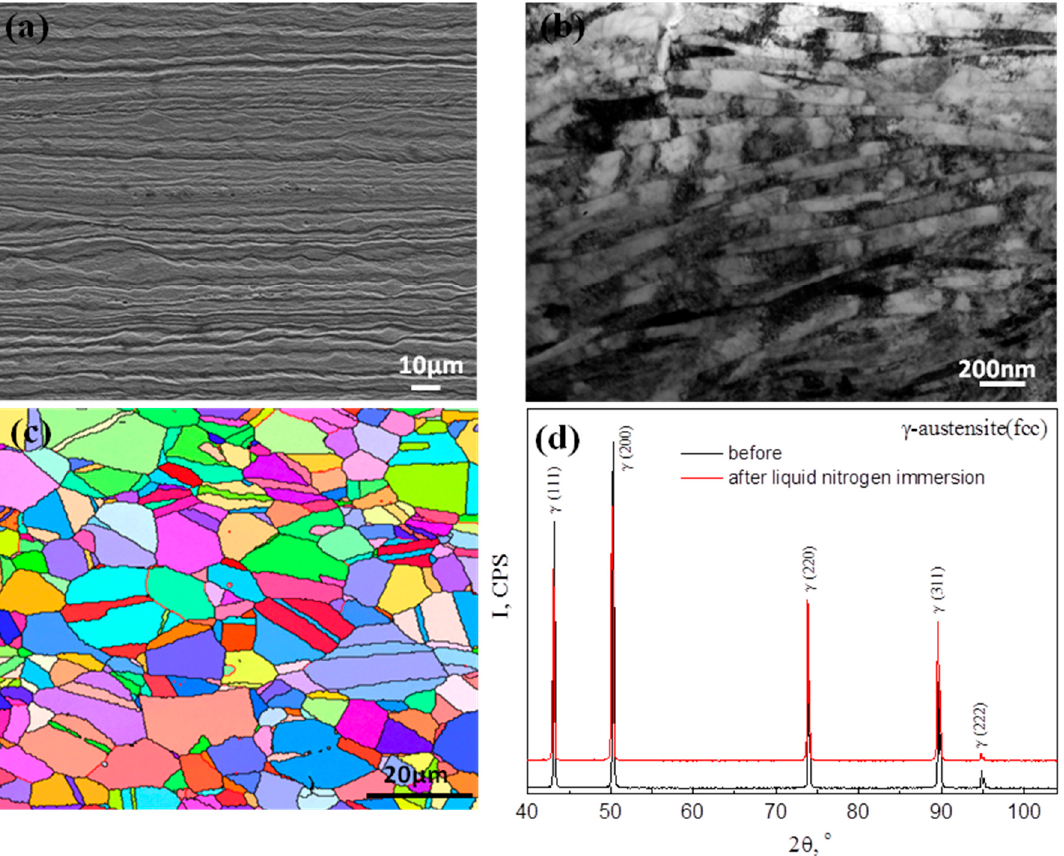
Figure 1. ( a ) SEM image and ( b ) TEM image showing the deformed microstructure of cold-rolled microstructure, Electron back-scattered diffraction (EBSD) orientation map; ( c ) recrystallised fine grain structure of the material that was cold rolled and annealed for 1 h at 800 °C; ( d ) X-ray diffractograms of samples prior to and following liquid nitrogen immersion for 20 min.